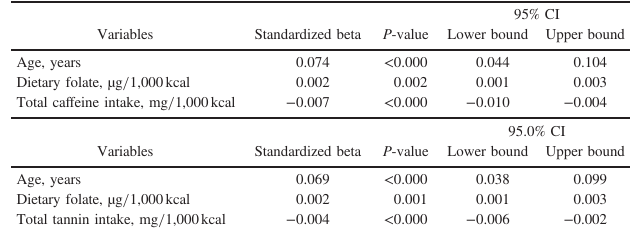
CI, con fi dence interval. Standardized beta indicates the standardized coe ffi cient.